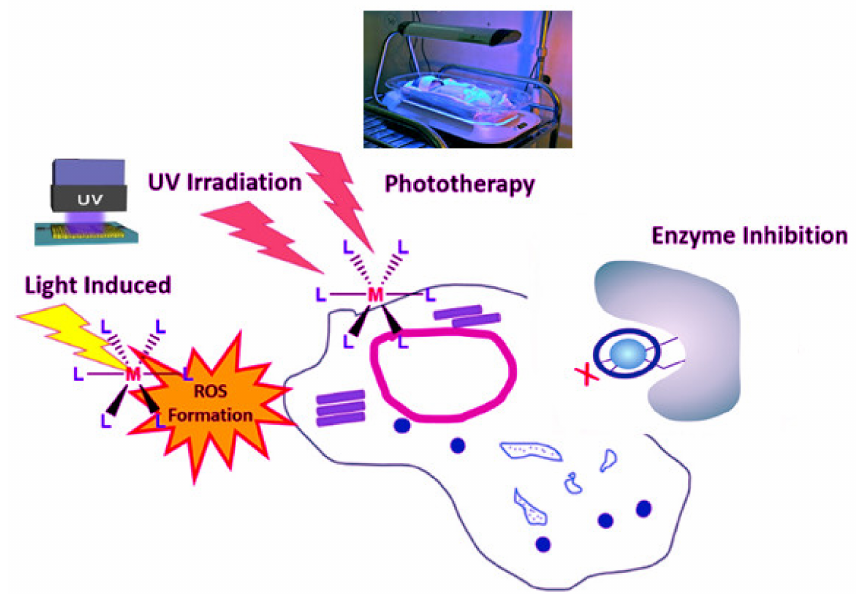
Figure 1. Overview of metal chelates’ mechanisms of action in living cells. Reproduced from